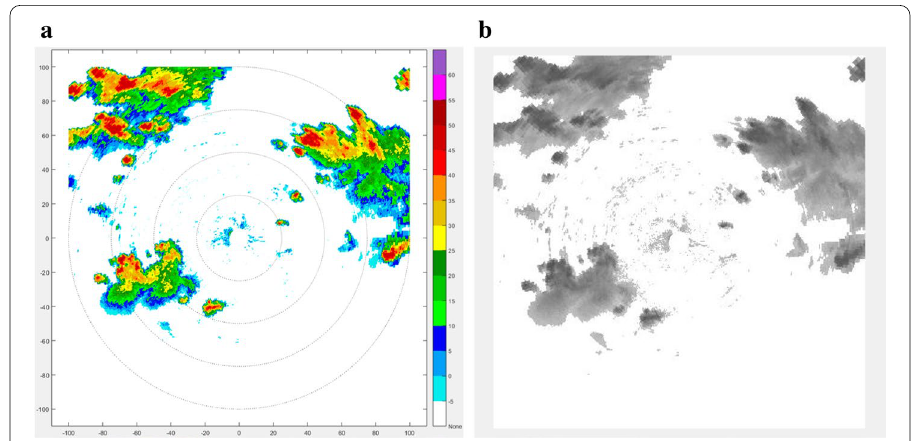
Fig. 3 Standardization of radar reflectivity CAPPI data, a origin, b Standardization